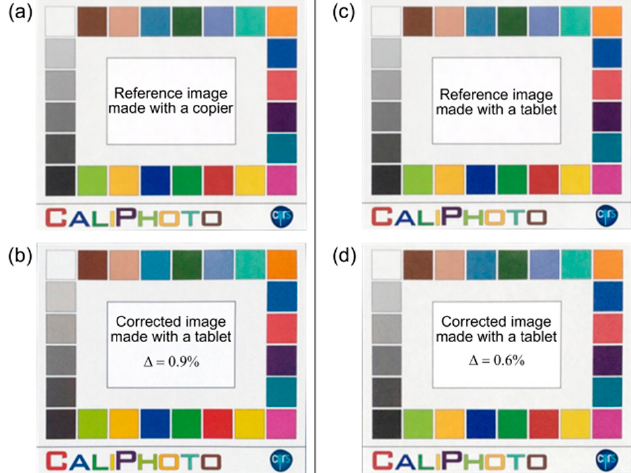
Figure A2. Effects of using different cameras during the CaliPhoto image processing. ( a ) Reference image of the colour plate made using a photocopier (Ricoh MP C2504ex) and ( b ) image of the same colour plate made using a tablet camera (iPad) after correction (see details in Appendices B and C). The value of ∆ given by Equation (1) (see main text) is 0.9%. When using the tablet camera throughout (i.e., to make the reference image of the colour plate, image in ( c ), and the image to correct) the value of ∆ is decreased to 0.6%, as displayed in ( d ).